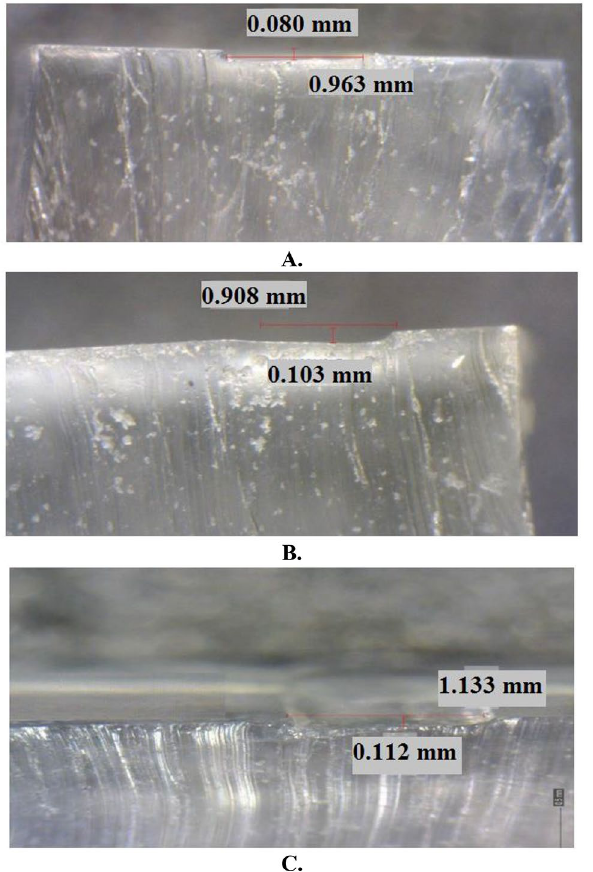
Fig. 13 Effect of voltage changes on dimensions of channels cre- ated in process in conditions of zero rotational speed, feed rate of 0.6 mm/min, NaOH electrolyte solution with 25% concentration and voltages of a 38 V, b 40 V and c 42 V